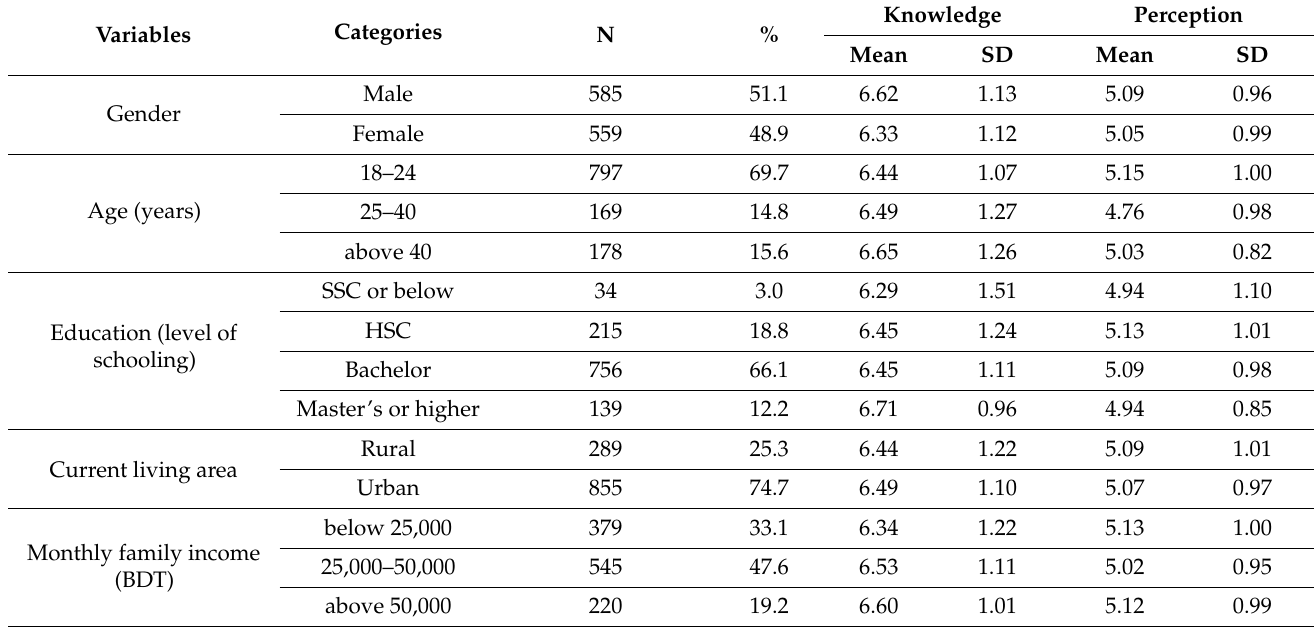
Table 1. Demographic characteristics, and knowledge and perception scores (mean ± SD) towards COVID-19 vaccine among general population of Bangladesh (N =